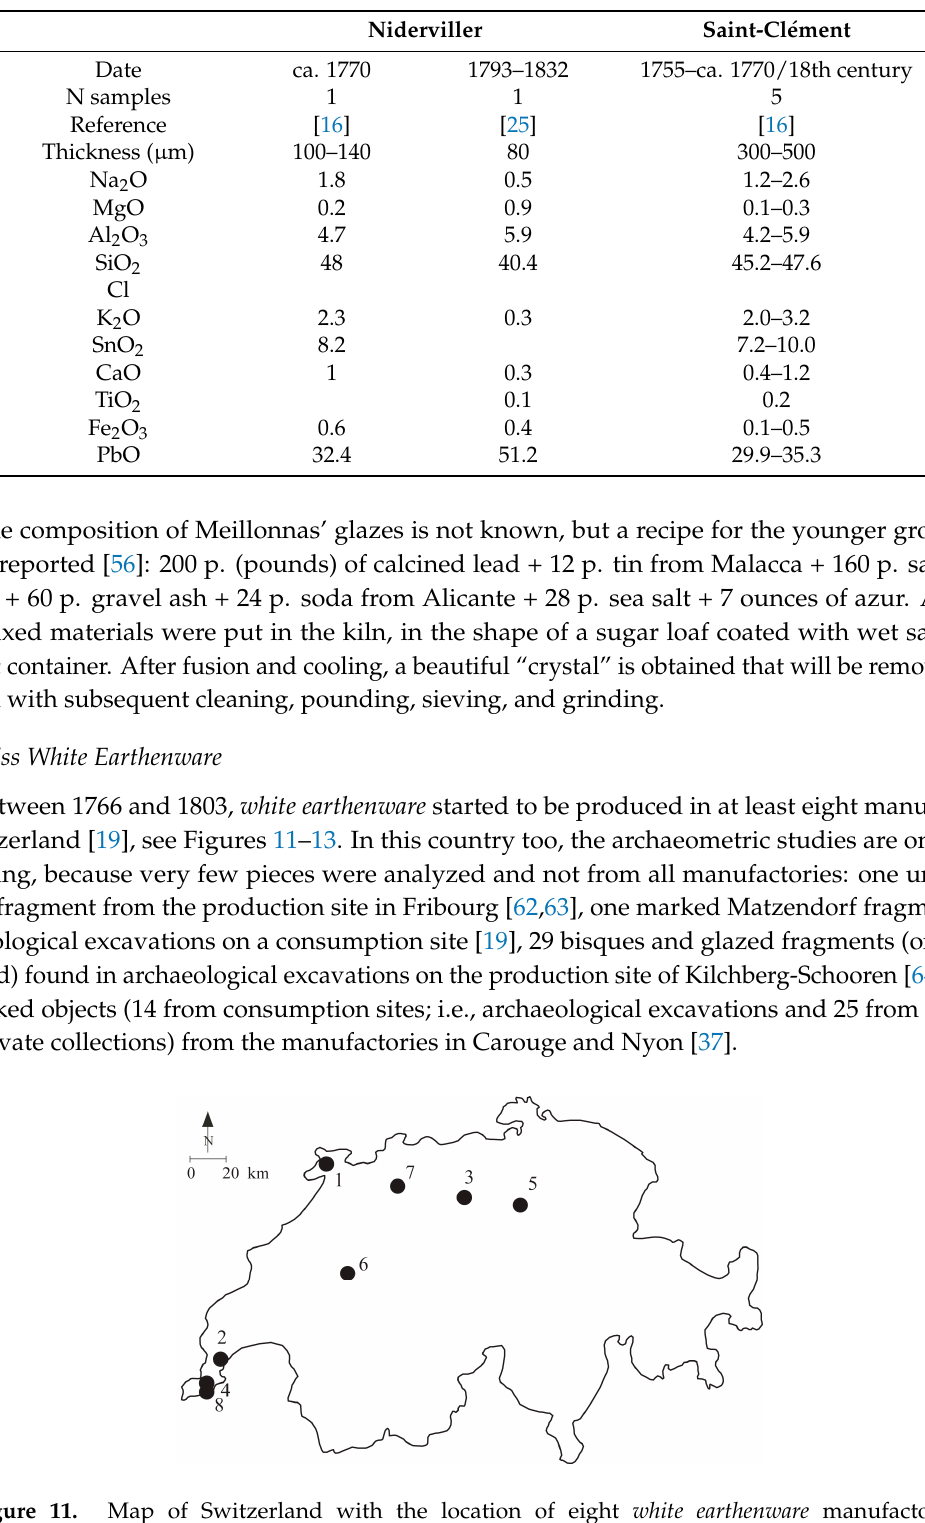
Table 5. Thicknesses and SEM-EDS analyses (wt %) of opaque (white) and transparent glazes of French CaO rich white earthenware .